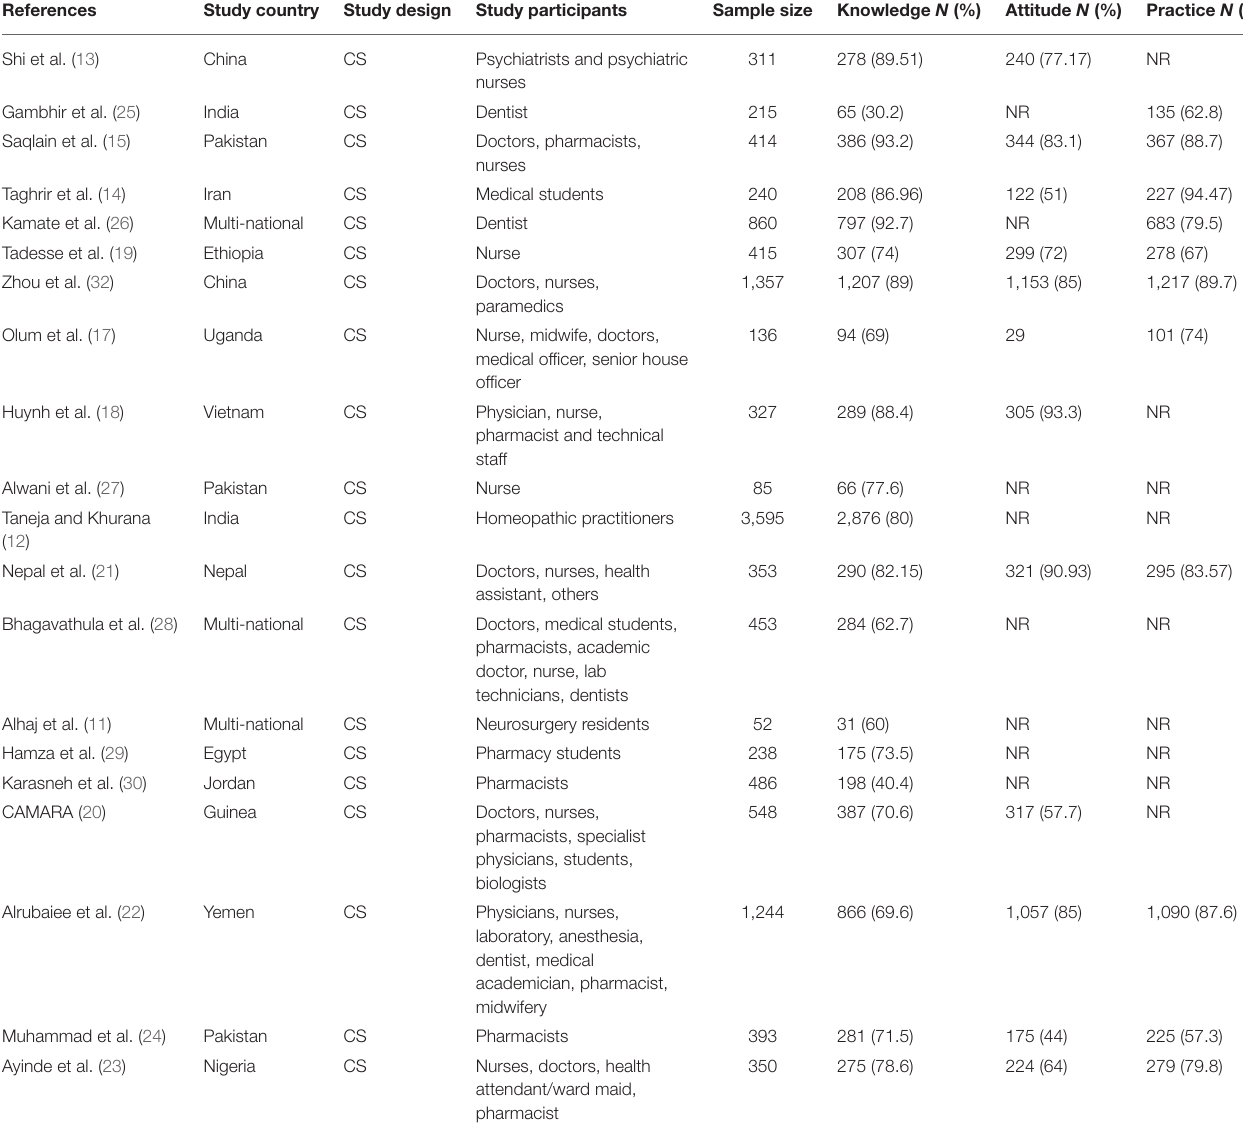
TABLE 2 | Characteristics of the included studies in the systematic